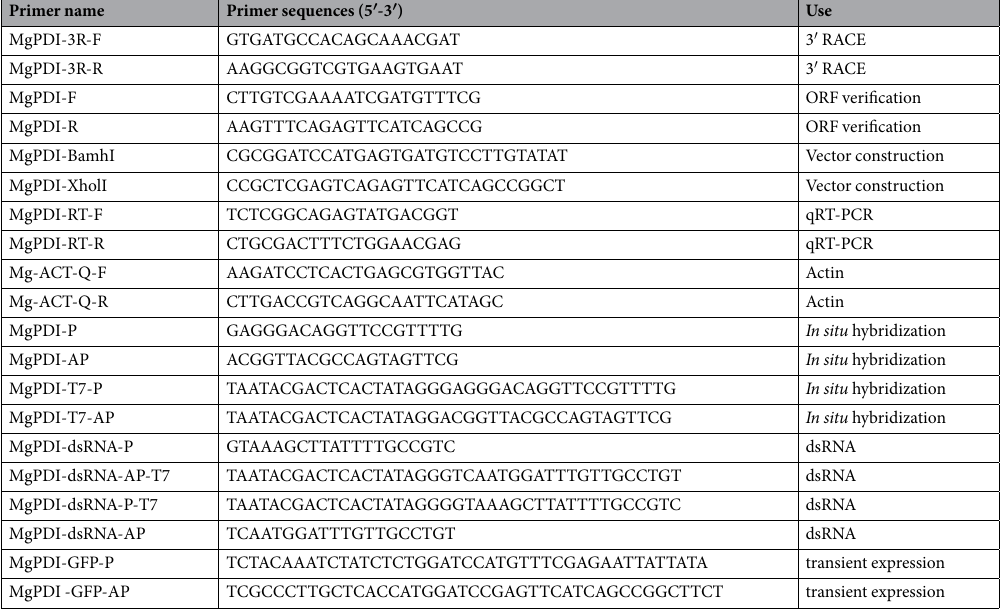
Table 1. Primer sequences used in this study. All primers were 5 ′ - 3 ′